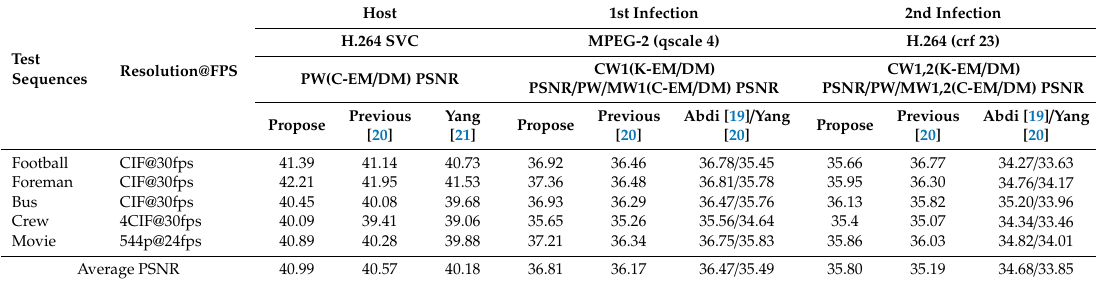
Table 5. PSNR results of pathogen, contagion and mutant watermarks by MPEG2 and H.264 / MPEG4 AVC for low